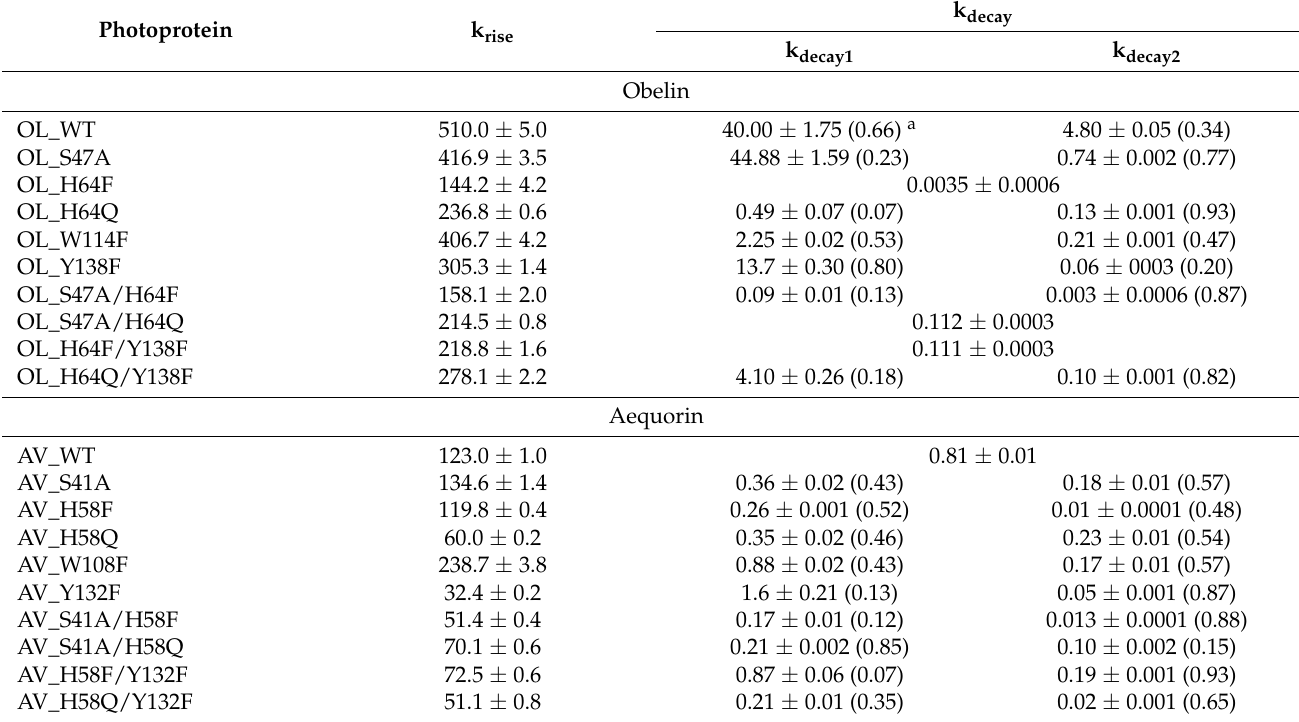
Table 3. Kinetics of bioluminescent reactions of obelin and aequorin